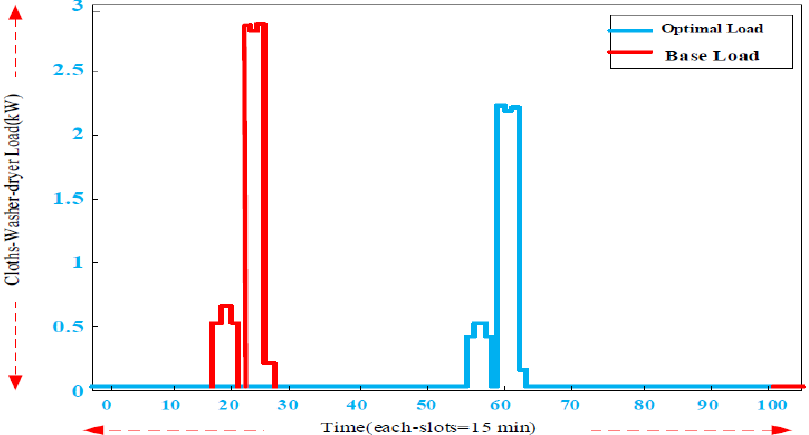
Figure 13. Comparison of consumption profile of washing machine and dryer before and after applying the proposed method.